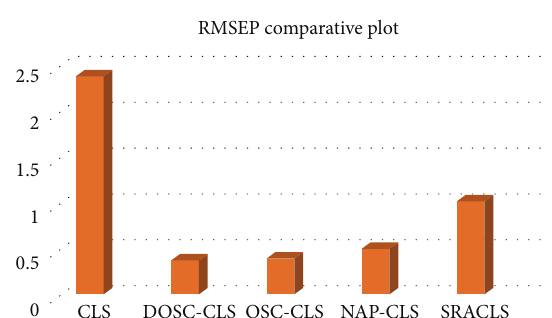
Figure 4: RMSEP comparative plot for the prediction of test set samples: 1-SRACLS, 2-NAP-CLS, 3-OSC-CLS, 4-DOSC-CLS, and 5- CLS